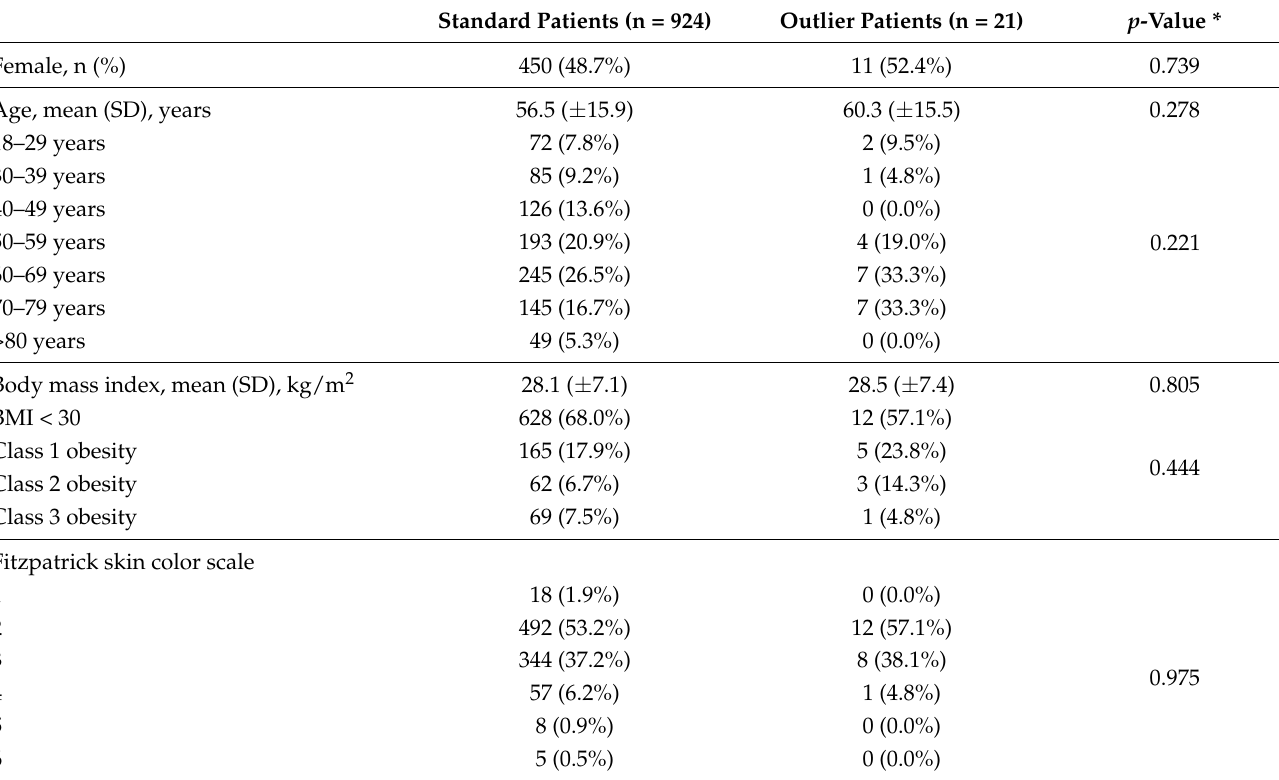
Table 2. Demographic and clinical characteristics of ‘standard’ Patients and ‘Outlier’ Patients (ac- cording to the 95% IC Bland–Altman